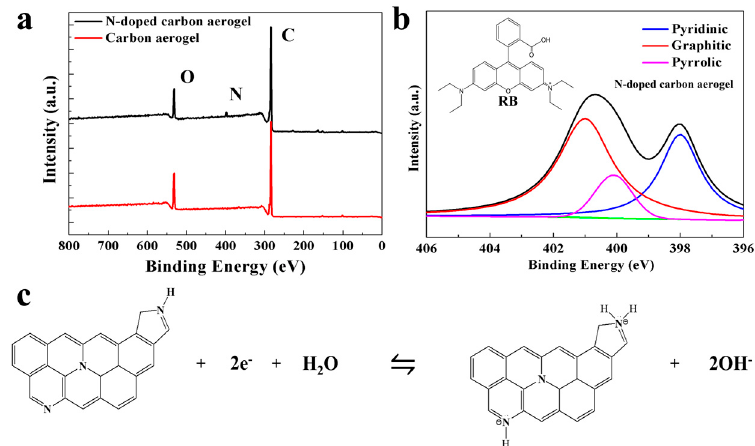
Figure 3. ( a ) X-ray photoelectron spectroscopy (XPS) spectra of carbon aerogel and N-doped carbon aerogel; ( b ) high-resolution XPS spectra of the fitted N 1s of N-doped carbon aerogel; ( c ) the reaction mechanism of the pseudocapacitance effect of pyridine N and pyrrolic N in KOH aqueous electrolyte.